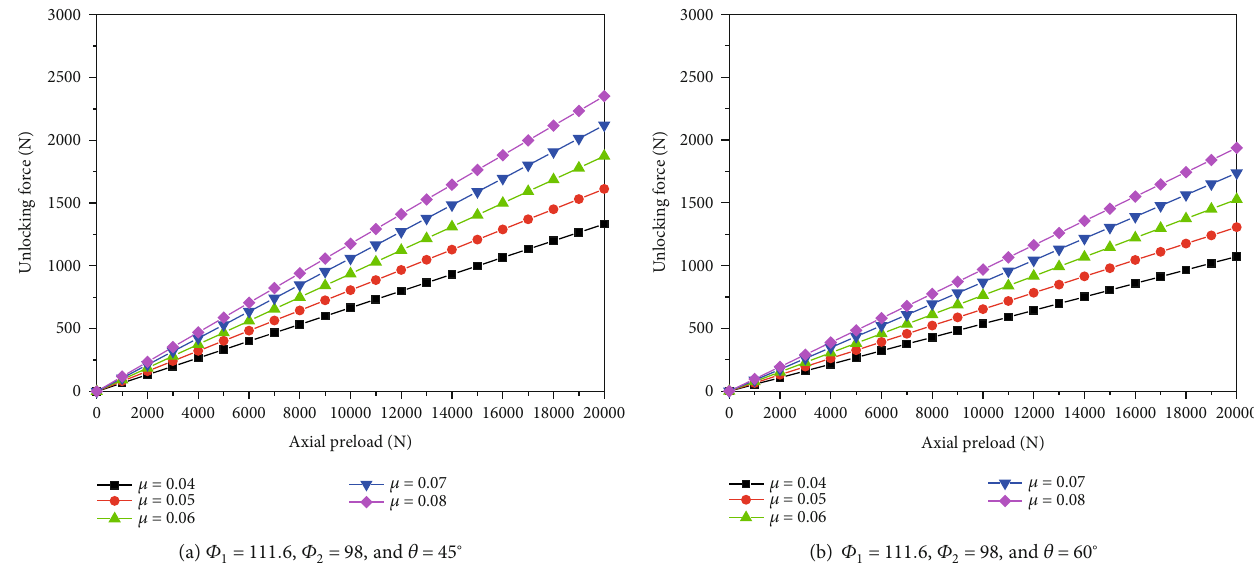
Figure 23: In fl uence of friction coe ffi cient on unlocking force of the fi nger lock.